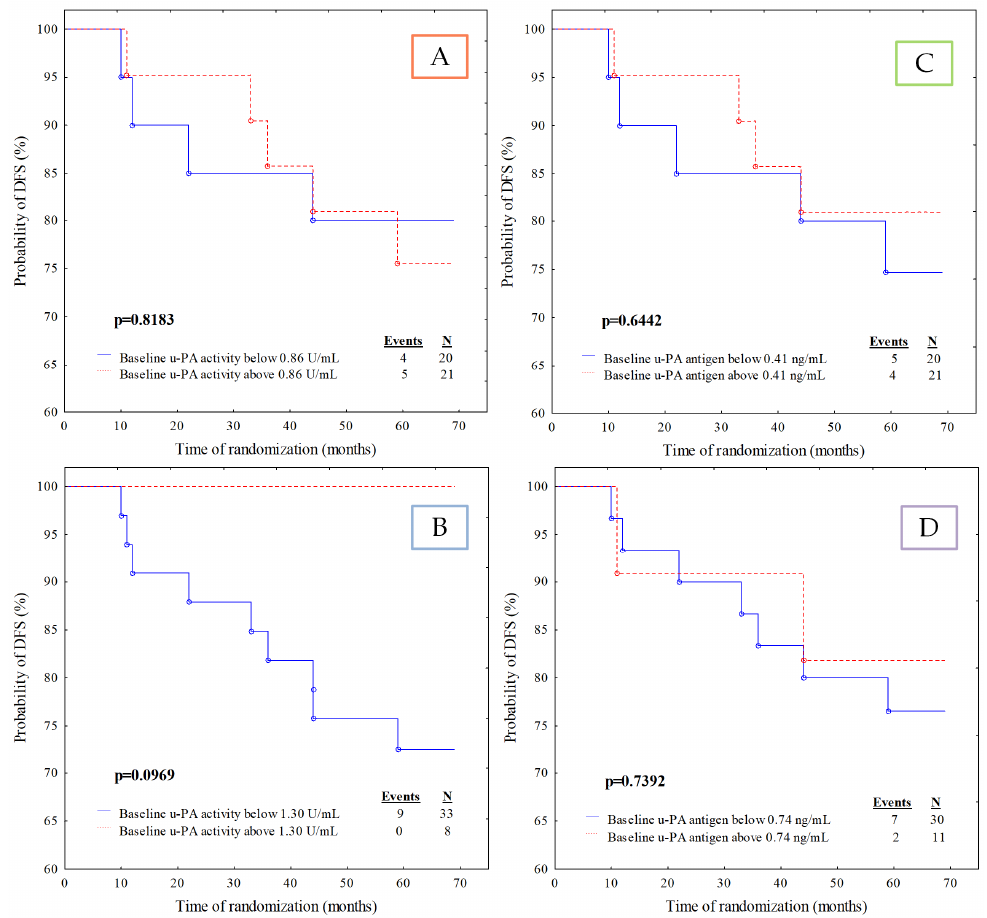
Figure 4. Kaplan–Meier curves for the disease-free survival (DFS) analysis of the studied population regarding ( A ) u-PA activity divided according to median value cut-off; ( B ) u-PA activity divided according to ROC cut-off; ( C ) u-PA antigen divided according to median value cut-off; ( D ) u-PA antigen divided according to ROC cut-off.